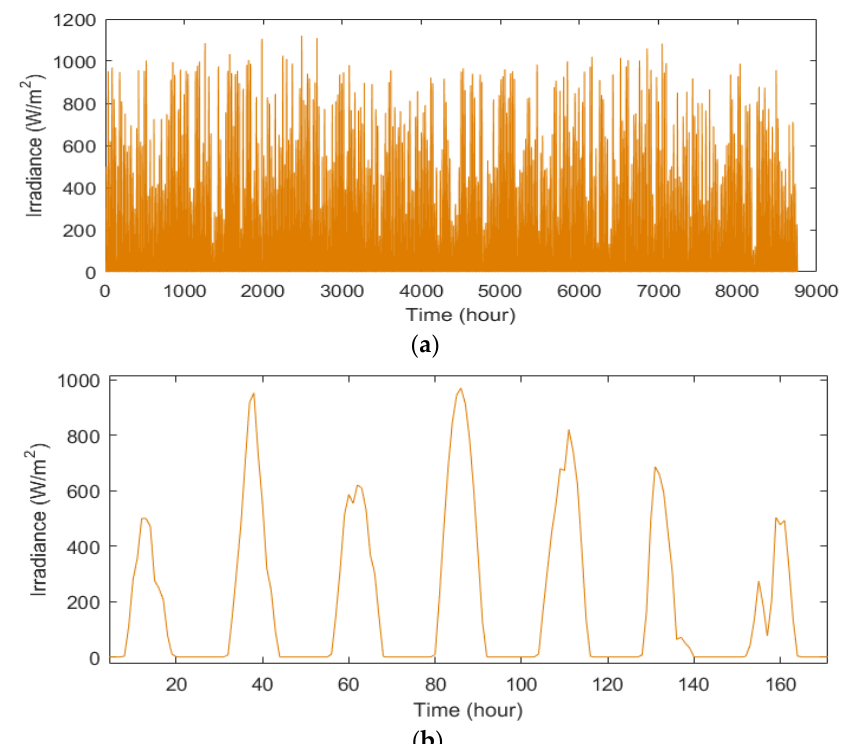
Figure 3. Irradiance of Kuala Lumpur during ( a ) a year and ( b ) a week.